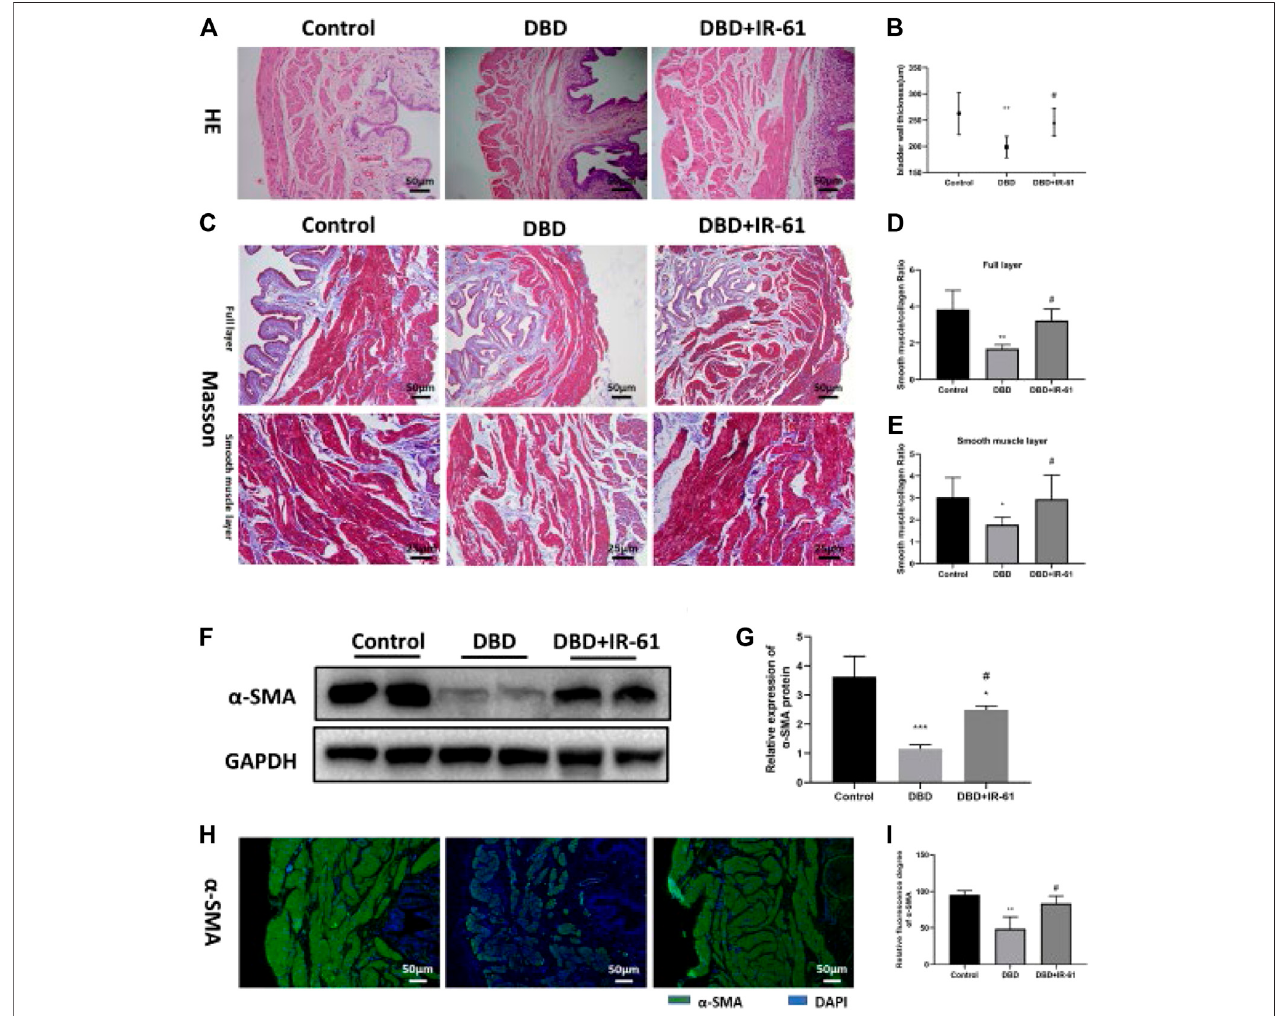
FIGURE 3 | IR-61 prevented DM-induced histopathological changes. (A) Representative HE staining images of bladder tissues from each group. (B) Bladder wall thickness(BWT).Scalebar (cid:2) 50 μ m.BWTmeasuredfromHEimages. (C) RepresentativeMasson ’ strichromestainingimagesofbladdertissuesfromeachgroup. (D,E) BladdersmoothmuscletocollagenratiointheentirebladderwallandsmoothmusclelayerdeterminedbyMasson ’ strichromeimages. (F , G) Levelsof α -SMAinbladder tissues detected by Western blot. (H , I) Levels of α -SMA in bladder tissues detected by immuno fl uorescence, scale bar (cid:2) 50 μ m. Data indicate the mean ± SD (* p < 0.05, **** p < 0.0001 vs. control group; # p < 0.05, ## p < 0.01 vs. DBD group).